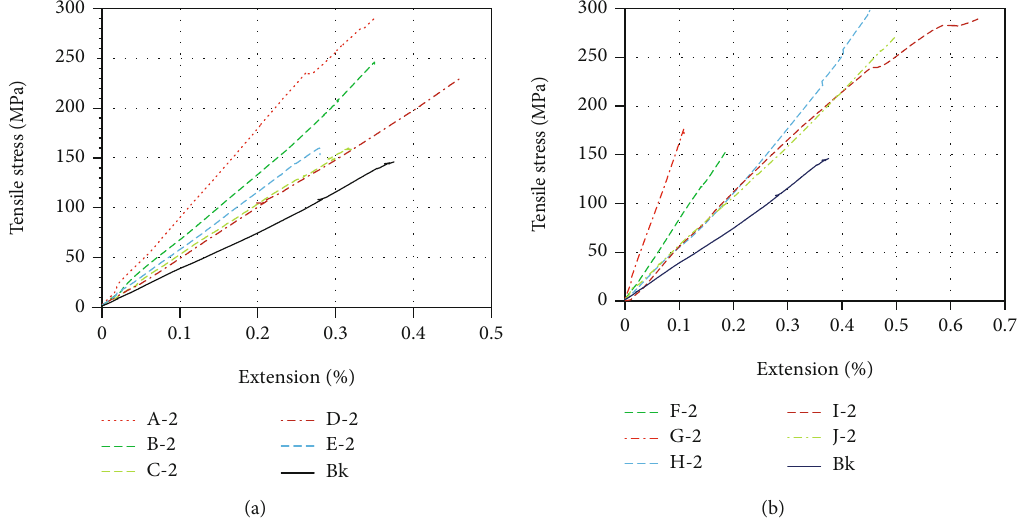
Figure 9: Tensile stress-strain curves for (a) dielectric nano fi llers and (b) magnetic (A: MWCNTs, B: SiC, C: Gp, D: CB, E: MnO G: CoO, H: NiO, I: ZiO, J: Fe